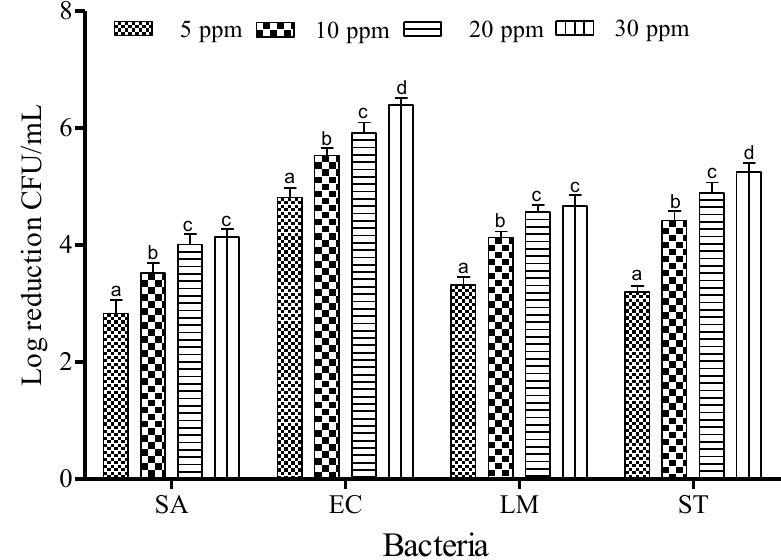
Figure 4. Inactivation of different foodborne pathogens treated with slightly acidic electrolyzed water (40 °C and 1 min) at different concentrations. Vertical bars represent means of three replications ± standard deviation. Bars labeled with different letters indicate significant differences at p < 0.05. SA: S. aureus , EC: E. coli O157:H7, LM: L. monocytogenes , ST: S. Typhimurium . The initial level of each foodborne pathogen was 8.86, 7.68, 7.43, and 8.56 for EC, SA, LM, and ST, respectively.